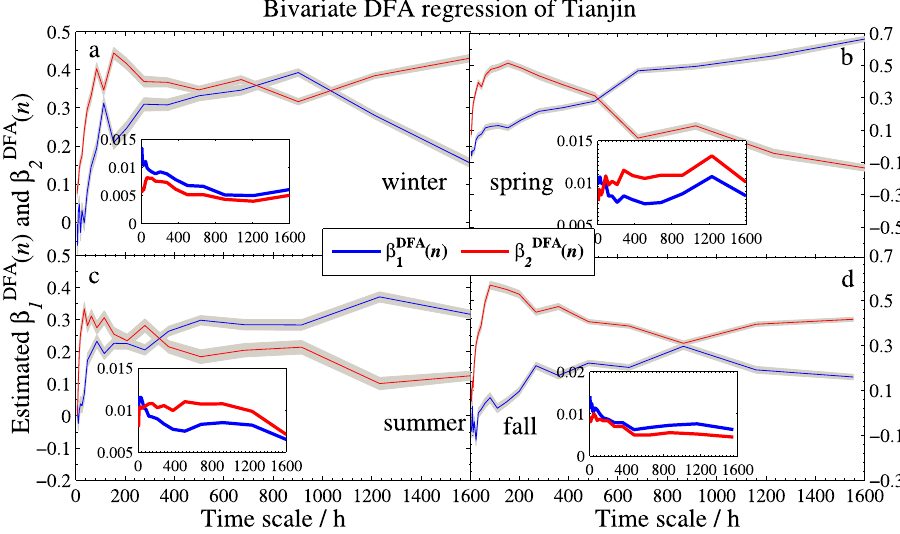
Figure 5. Bivariate DFA regression of Tianjin with the same legend as in Fig. 4. Here, subscripts 1 and 2 denote Beijing and Baoding, respectively.